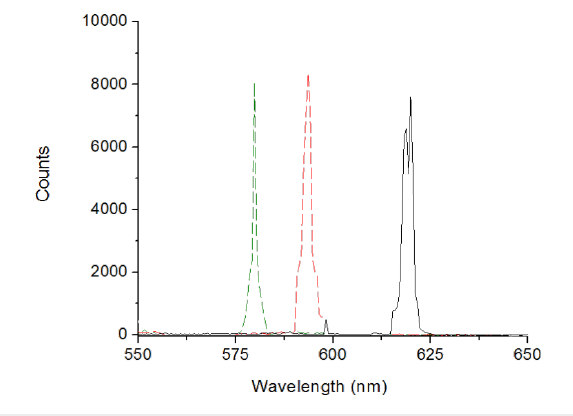
Figure 6: Blue shift of the emitted laser wavelength, measurements acquired at 28 °C (black solid line), at 40 °C (red dashed line) and at 46 °C (green dashed line),